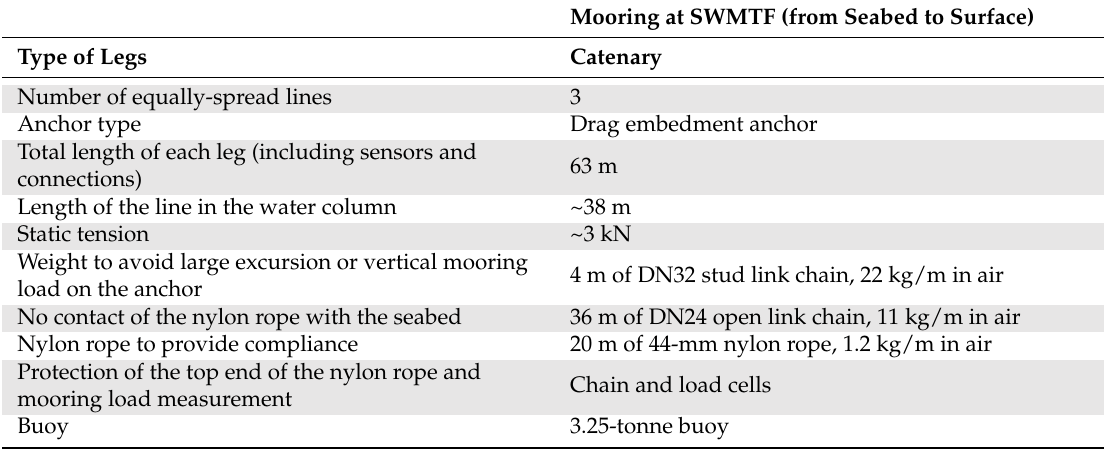
Table 2. Summary of mooring line components at SWMTF.